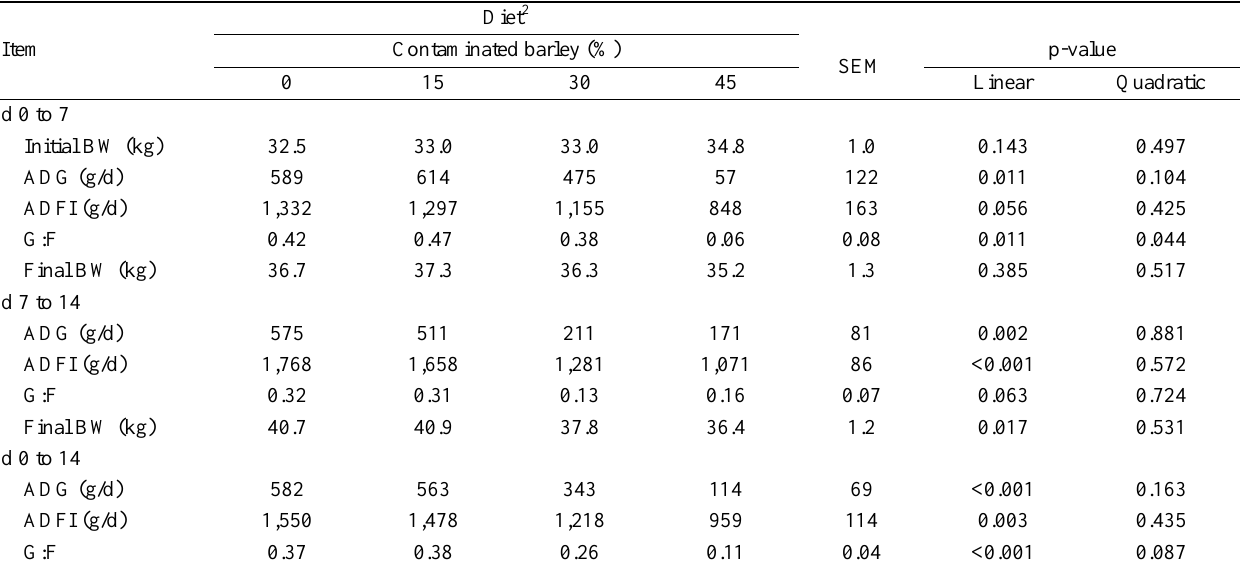
Table 4. Growth performance of pigs fed experimental diets containing increasing amounts of barley naturally contaminated with Fusarium mycotoxins 1 , Exp.